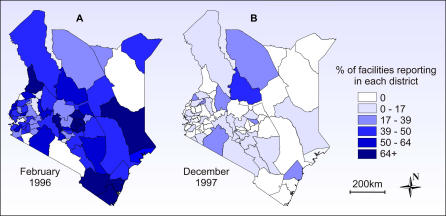
Percentage of Government Health Facilities in Each Kenyan District (Fourth Level Administrative Unit) Submitting a Monthly Outpatient Morbidity Report to the HMISThe 2 mo shown are (A) the most complete (February 1996) and (B) the least complete (December 1997) during the 84-mo study period January 1996–December 2002.